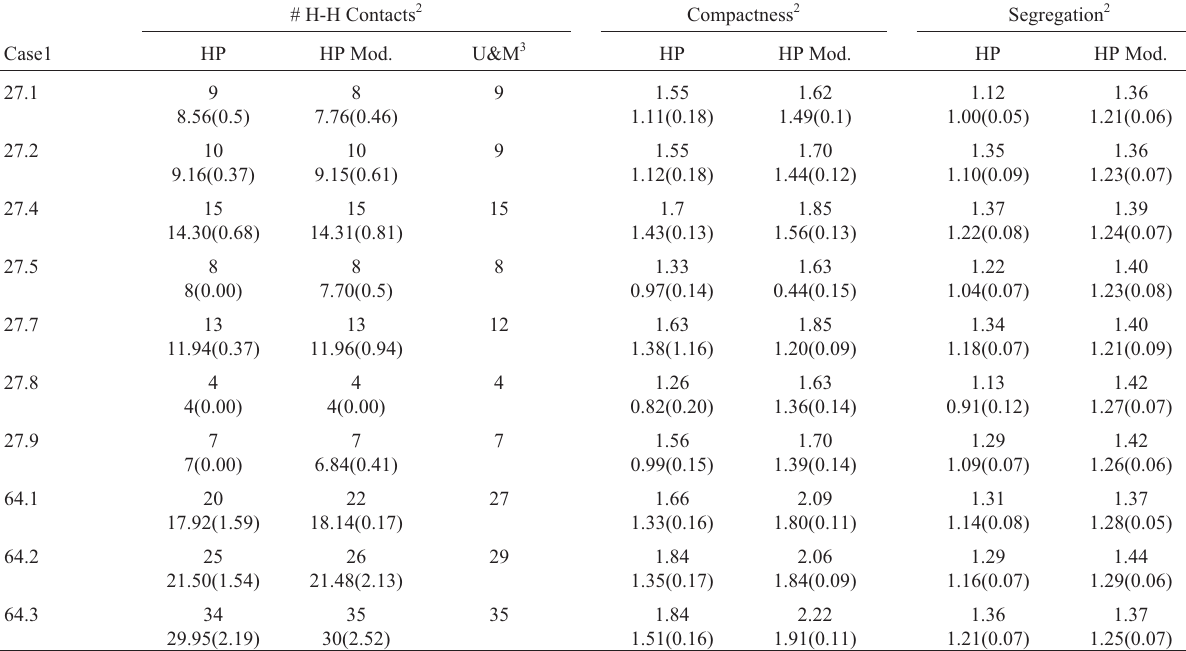
Table 2 - Results from 50 runs of the 10 cases. a , best result, b , average and c , standard deviation. The runs allowed for a maximum of 3,500,000 function evaluations using the islands’ algorithm with the modified selection scheme and the mp